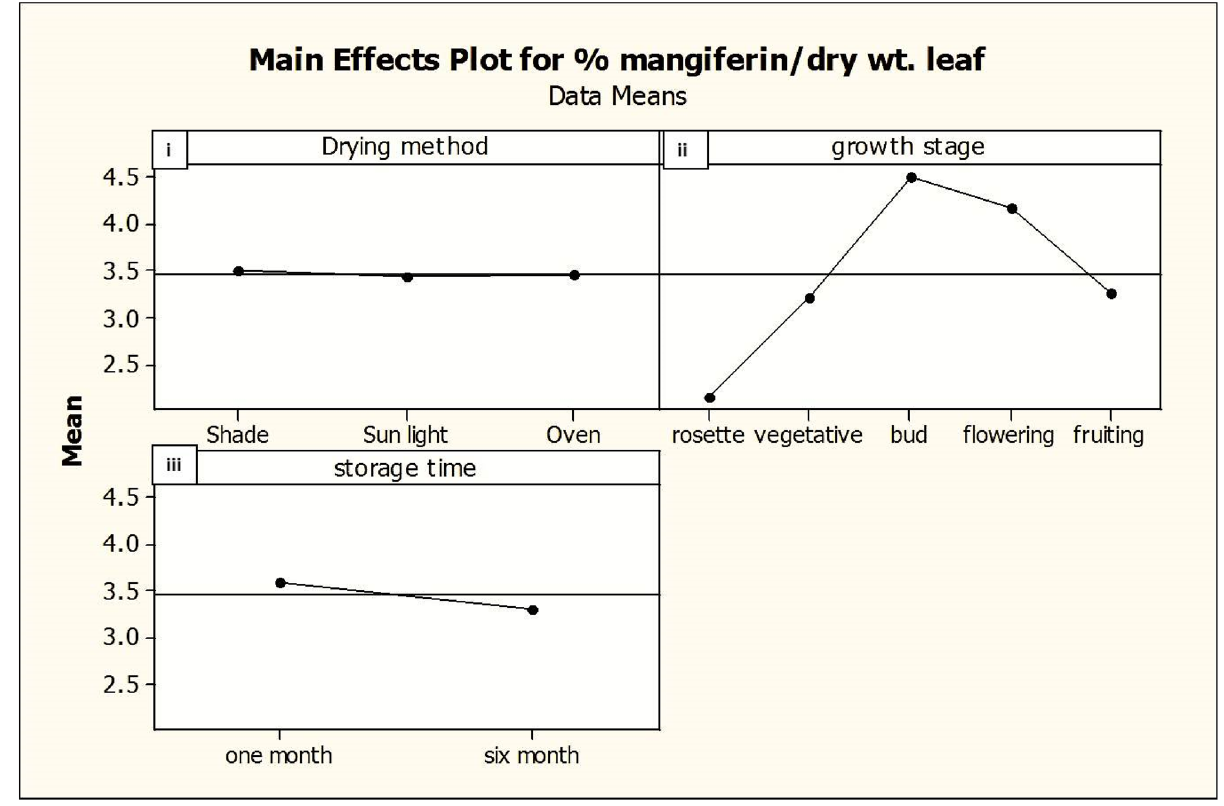
Figure 8. Main plots of growth stage, drying method and storage periods for mangiferin yield from Swertia chirata leaves. Dot is the mean value of mangiferin content.